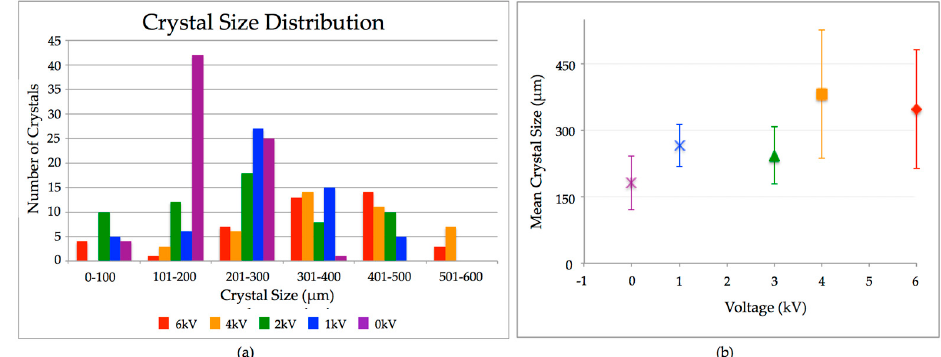
Figure 2. Size distribution of Glucose Isomerase crystals grown by the microbatch method in the presence of an external DC electric field for 48 h. In total, 360 micro batch wells were probed. ( a ) Crystal size for the five voltages probed; ( b ) Mean crystal size as a function of applied voltage. The largest crystals were obtained for DC voltages between 4 and 6 kV.